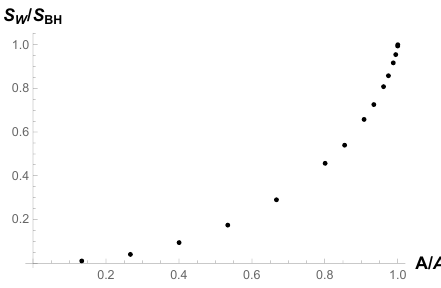
Figure 4 . Shown is the ratio of entropy of the winding-mode condensate to the black hole entropy for different values of A . The ratio approaches unity as A approaches A c from